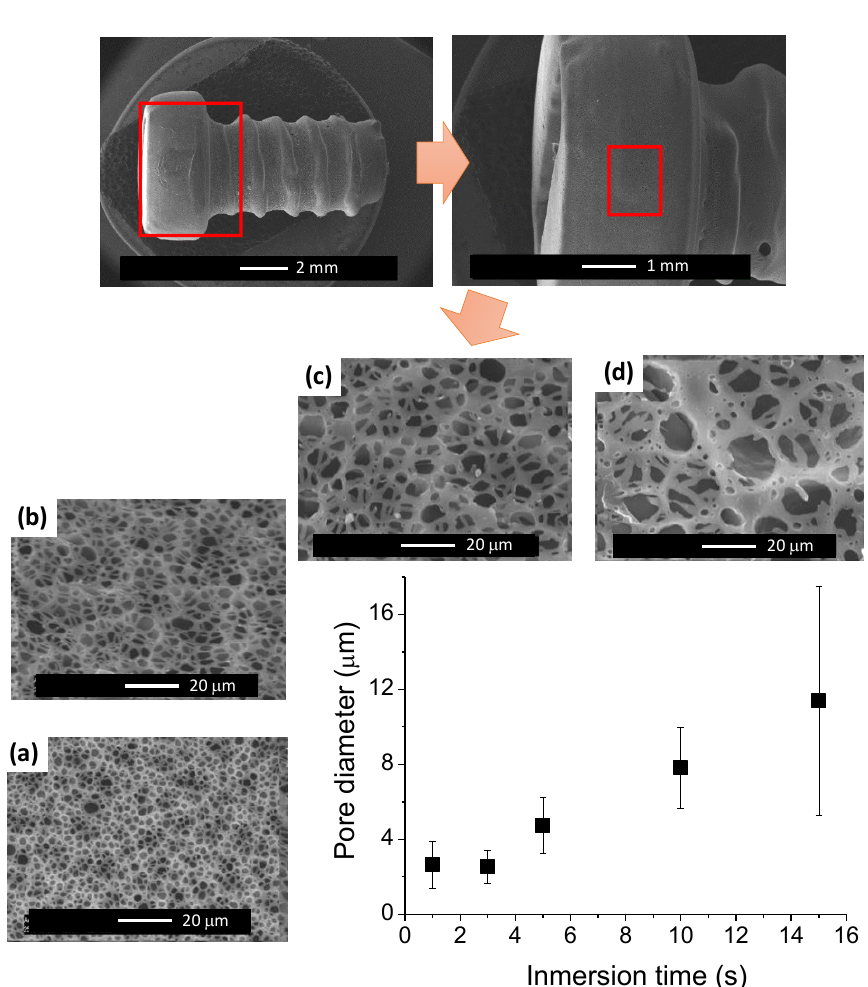
Figure 6. SEM images of the screw surface upon breath figures treatment immersing the sample in chloroform for ( a ) 3 s, ( b ) 5 s, ( c ) 10 s, and ( d ) 15 s.